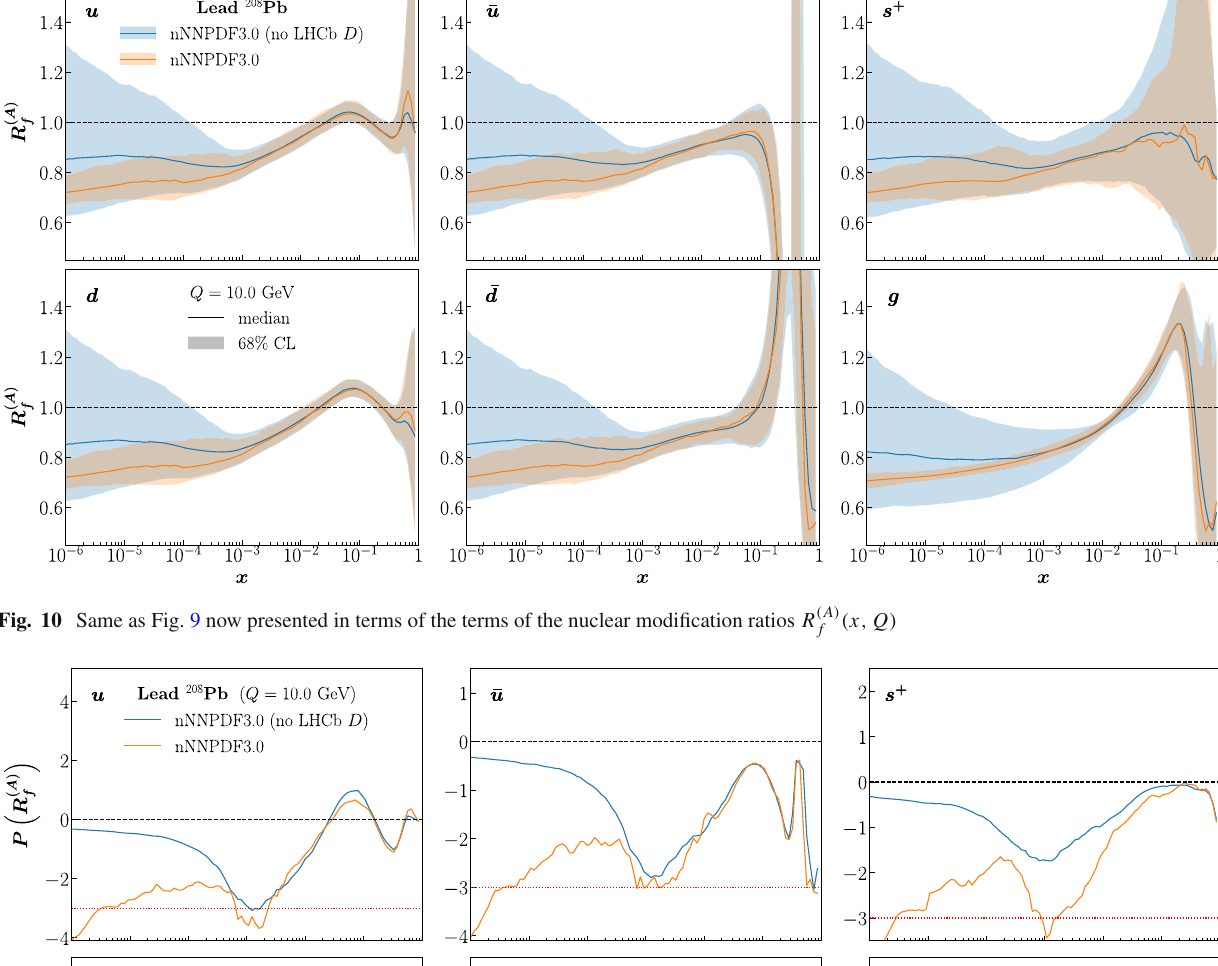
Fig. 11 Same as Fig. 10 now presented in terms of the pulls defined in Eq. (4.2). The dotted horizontal lines indicate the threshold for which nuclear modifications differ from zero at the 3 σ ( 5 σ) level